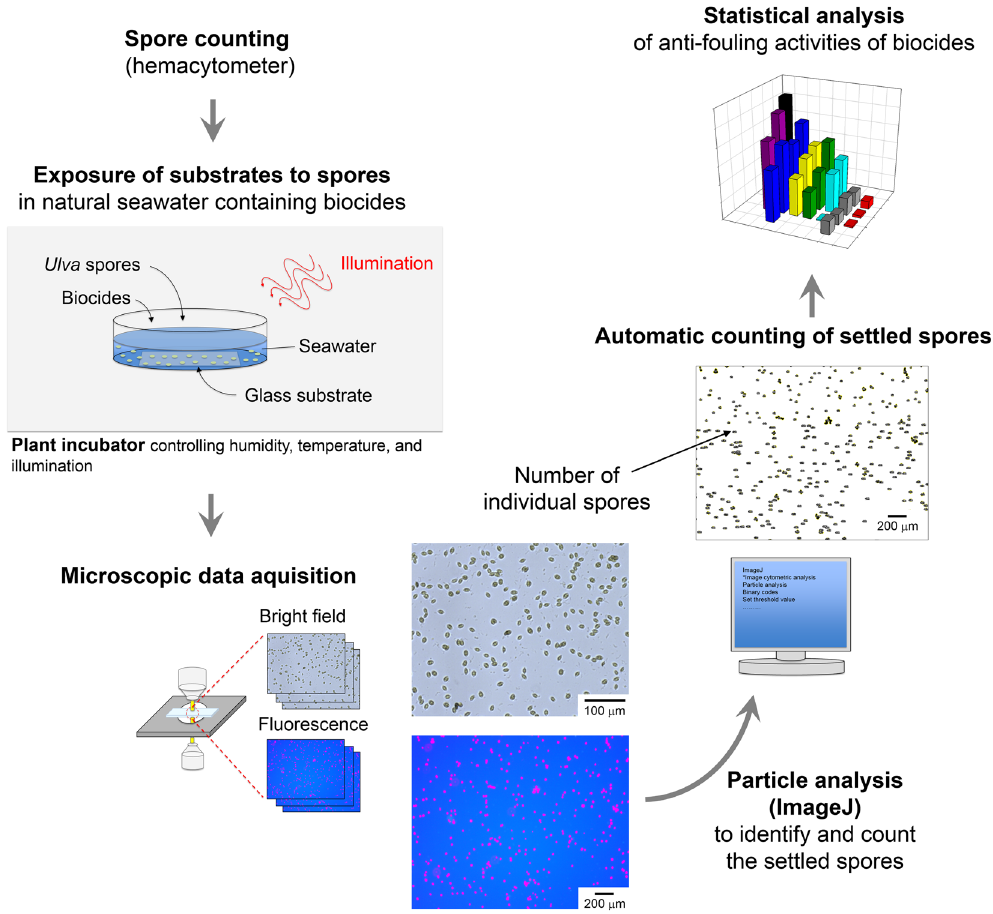
Figure 1. Schematic illustration of image cytometric analysis to quantitatively determine the antifouling activity of